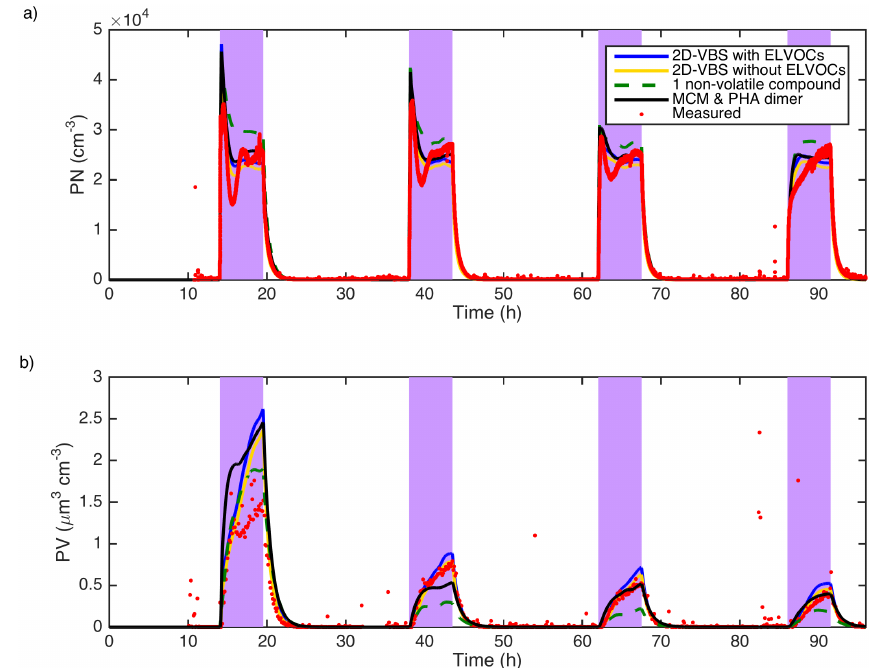
Figure 8. Modelled and measured (a) total particle number concentration and (b) total particle volume concentration. The model results are from simulations with the 2-D VBS and with or without ELVOC formation via ozonolysis and OH-oxidation of monoterpenes and sesquiterpenes (Reactions R1 and R2), from a simulation when the MCM compounds were used as the condensable organic compounds and considering PHA dimer formation with Eq. (7), and from a simulation with only one condensable non-volatile compound. The mass yield of the non-volatile compound formed from O 3 and OH oxidation of all monoterpenes and sesquiterpenes was